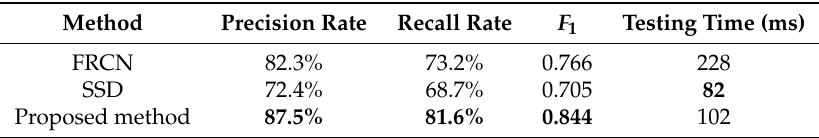
Table 7. Detection performance comparison between three